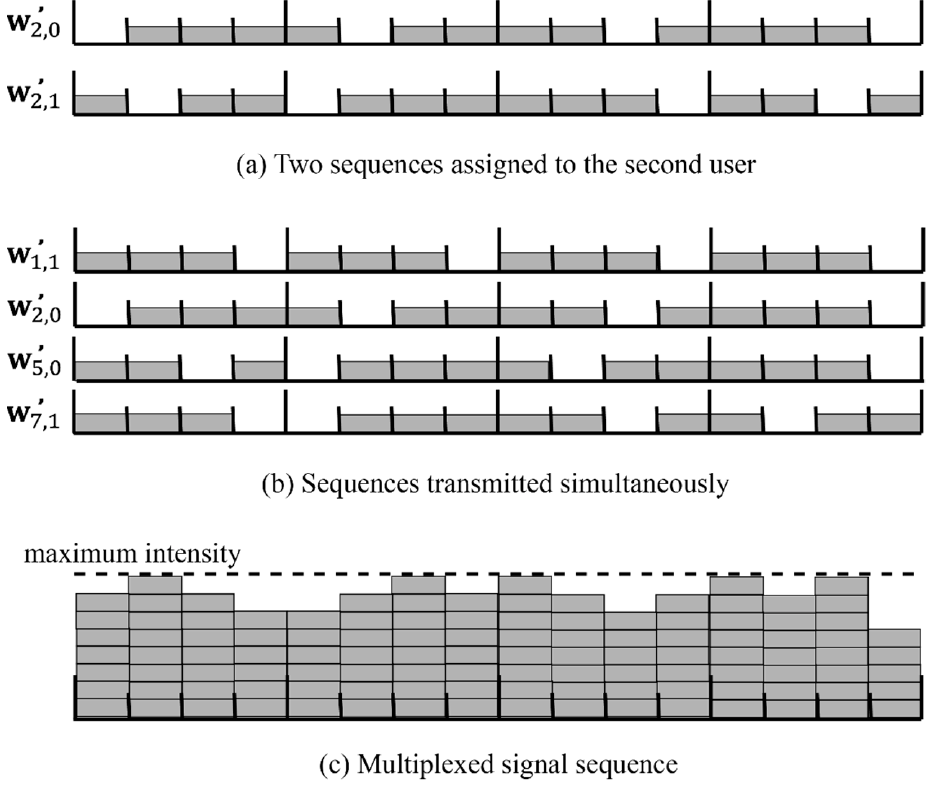
Figure 4. Examples of signal sequences for the EWO scheme with an inverted MPSC.